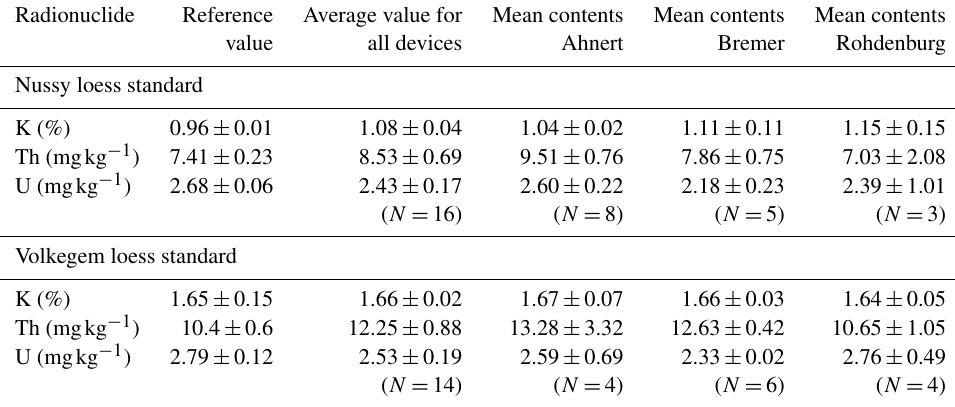
Table 7. Results from µ Dose measurements and reference values for K, Th and U contents of Nussy loess standard (upper part) and Volkegem loess standard (lower part). The values for K are given in percent, the values for U and Th are given in milligrams per kilogram (mgkg − 1 ). Reference values (and their associated 95% CIs) are according to Preusser and Kasper (2001) and De Corte et al. (2007). The 95% CIs for Nussy have been re-calculated based on the SD values provided by Preusser and Kasper (2001). Uncertainties of the µ Dose measurements correspond to 95% CIs. The table shows mean values for individual µ Dose devices as well as average values calculated as a mean of all measurements on the three